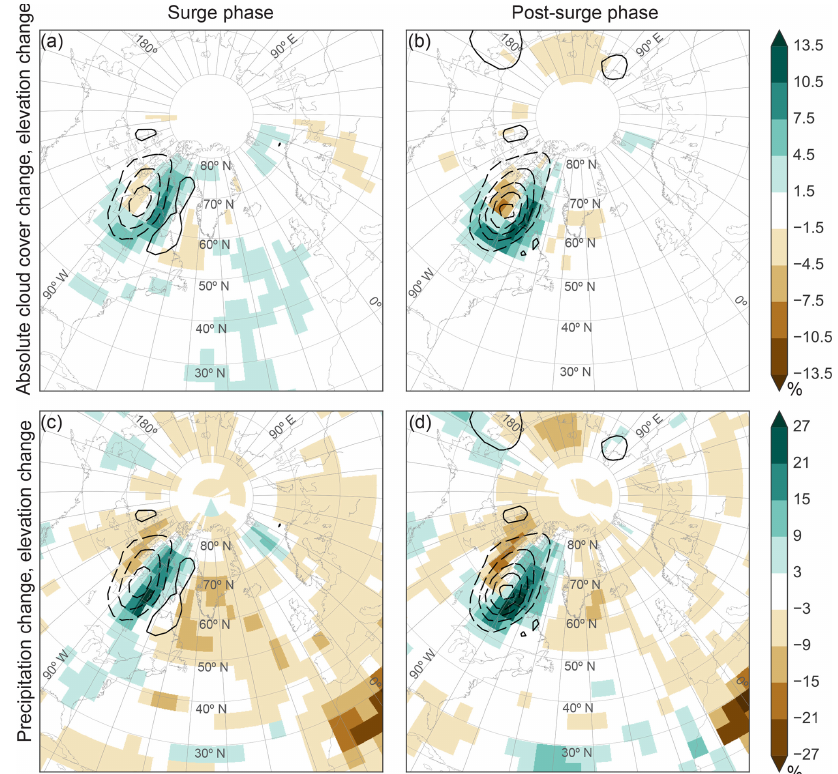
Figure 11. (a, b) Total cloud cover changes and (c, d) relative changes in precipitation. (a, c) Surge phase and (b, d) post-surge phase. Isolines mark the ice sheet elevation change at multiples of 100m. Dashed lines mark negative values. All changes are relative to the pre-surge phase. For a definition of the phases see Fig. 1 and Section 2.3. Stereographic projection around 67 ◦ N, 44 ◦ W with grid lines at multiples of 10 ◦